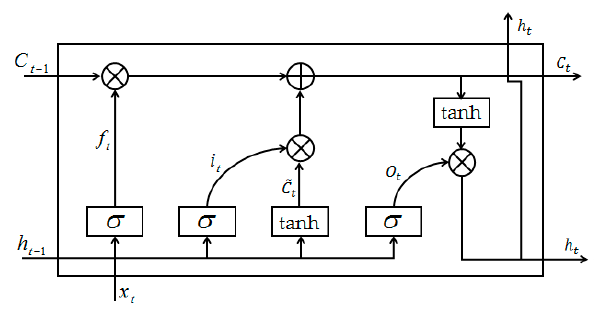
Figure 5. Memory unit structure of BiLSTM.